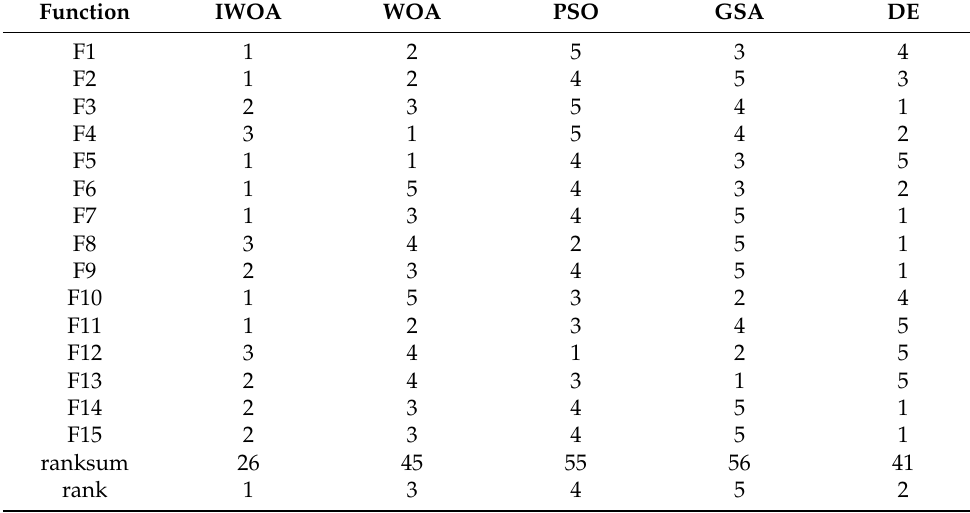
Table 5. Ranking of